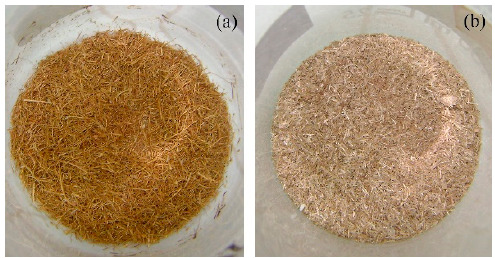
Figure 1. Treated fibers. ( a ) coir, and ( b ) BSF.